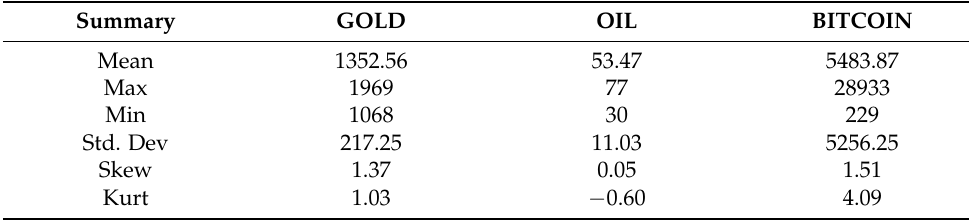
Table 3. Summary statistics of GOLD OIL Bitcoin prices (in US